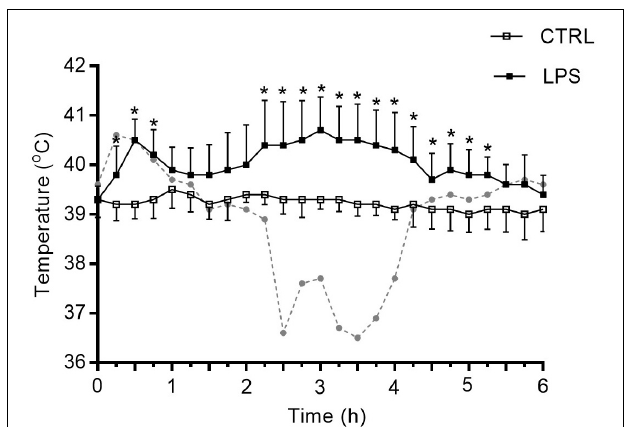
FIGURE 1 | Variation of body core temperature after intravenous injection of lipopolysaccharide. LPS induced a biphasic increase in body core temperature in 7/8 newborn lambs. (cid:78) : peaks of temperature. The dotted curve in gray represents the sole lamb who developed marked hypothermia following an initial increase in temperature. Results are illustrated as mean ± SD, * p < 0.05 vs. control condition